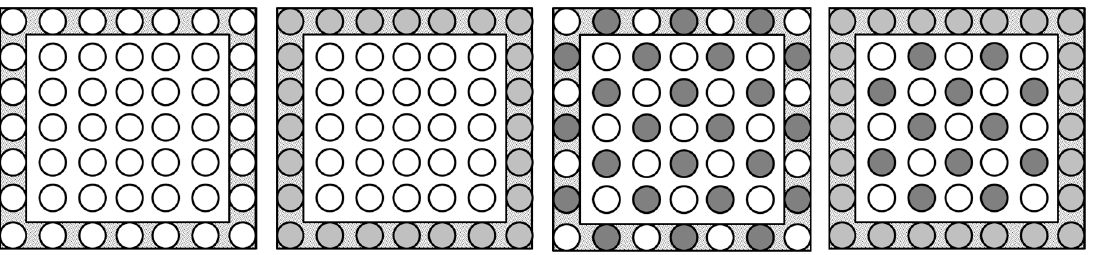
Figure 3. Layout of treatments used in the field study. One circle = one plant, where border and ‘inner’ plants are presented in a shaded (grey) and un-shaded (white) background, respectively. Key to circles/plants: white = cauliflower plant; light grey = turnip rape; dark grey = tomato. Each plant was set in its own 25 cm × 25 cm space within a 7 × 7 (i.e., 175 cm × 175 cm) planted